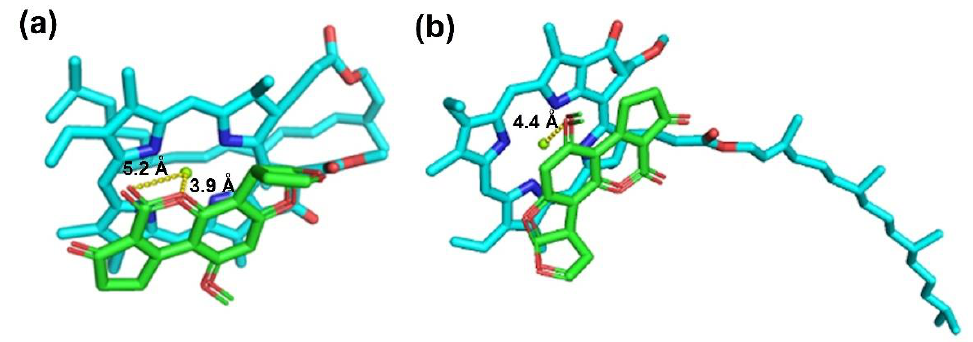
Figure 5. Interaction between chlorophyll and AFB 1 obtained by docking studies; ( a ) chl a 2 – AFB 1 complex, ( b ) chl a 1 – AFB 1 complex. complex, ( b ) chl a 1 –AFB 1